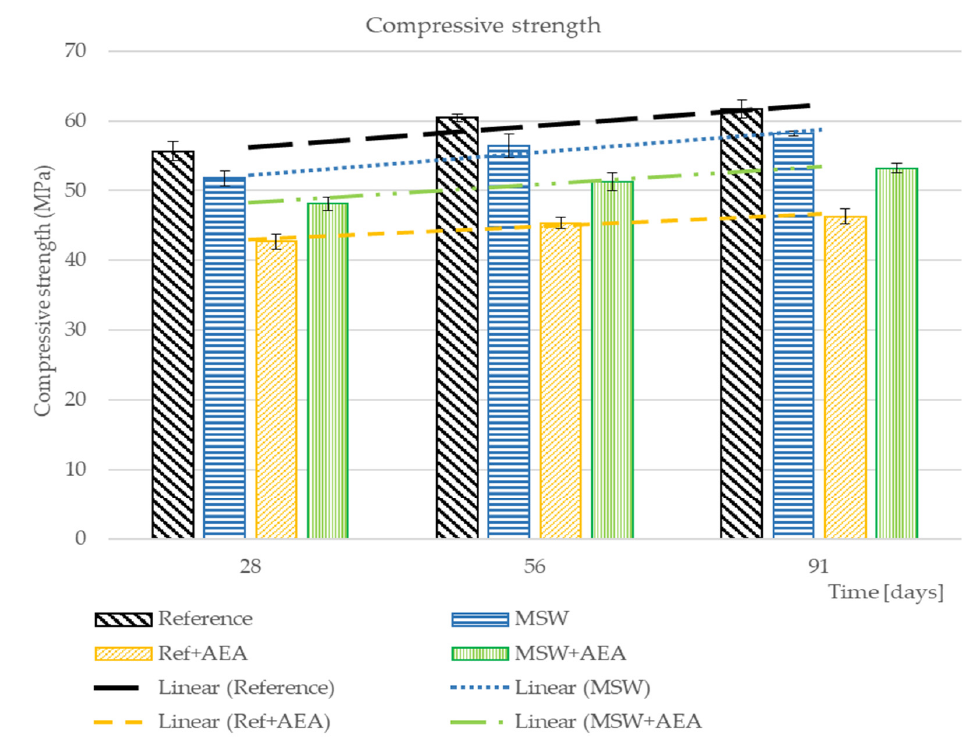
Figure 2. The values of compressive strength over the time. The increase in strength is gradual, irrespective of the composition of the mix. Thus, MSW does not significantly improve or deteriorate the progress of the strength properties. However, the lowest value of strength was achieved by the reference concrete with AEA. In contrast, the combination of MSW and AEA can slightly increase the strength. This phenomenon is caused by the different reaction of AEA with the replacement of fine aggregate. Further evaluation of compressive strengths is presented in the following chap- ters together with other results. It is a material with no significant chemical activity when in contact with water. Undoubtedly, the presence of MSW makes it necessary to use more superplasticizers and/or AEA to achieve a certain effect. This is mainly physical, due to the high water demands of MS, which is much higher than sand (and also cement, but in the research, MS was used as a sand replacement). MSW is very fine and contains wastes absorbing water. Some chemical interactions between MSW and admixtures cannot be ruled out, but this requires further research. 3.2. Diffusion Coefficient The diffusion coefficient at different times is a result calculated from the electrical resistivity, and it is an ideal parameter for the purpose of evaluating concrete degradation. The lower the diffusion coefficient is the higher the durability of concrete in an aggressive environment. Figure 3 shows the results for all the selected time points since the concret- ing.